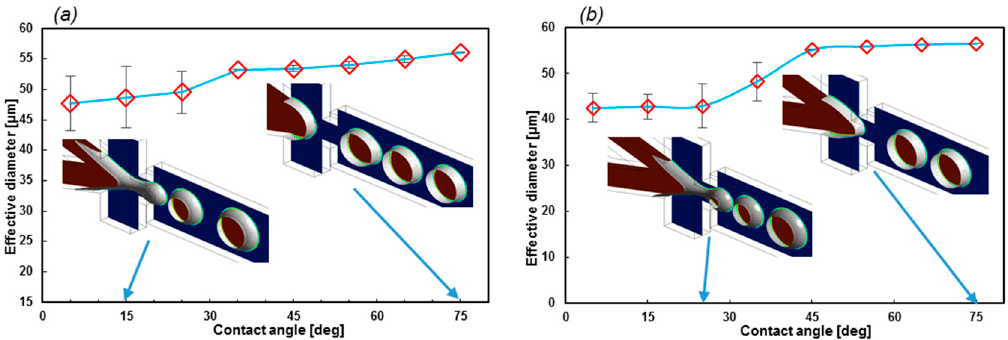
Figure 8. ( a ) Here, σ = 0.06 and ( b ) σ = 0.05207 N/m for EF = 2.63. The average droplet diameter for the first 10 droplets. The superhydrophobic wall contact angles produce a less stable regime. The red color shows the medium phase.